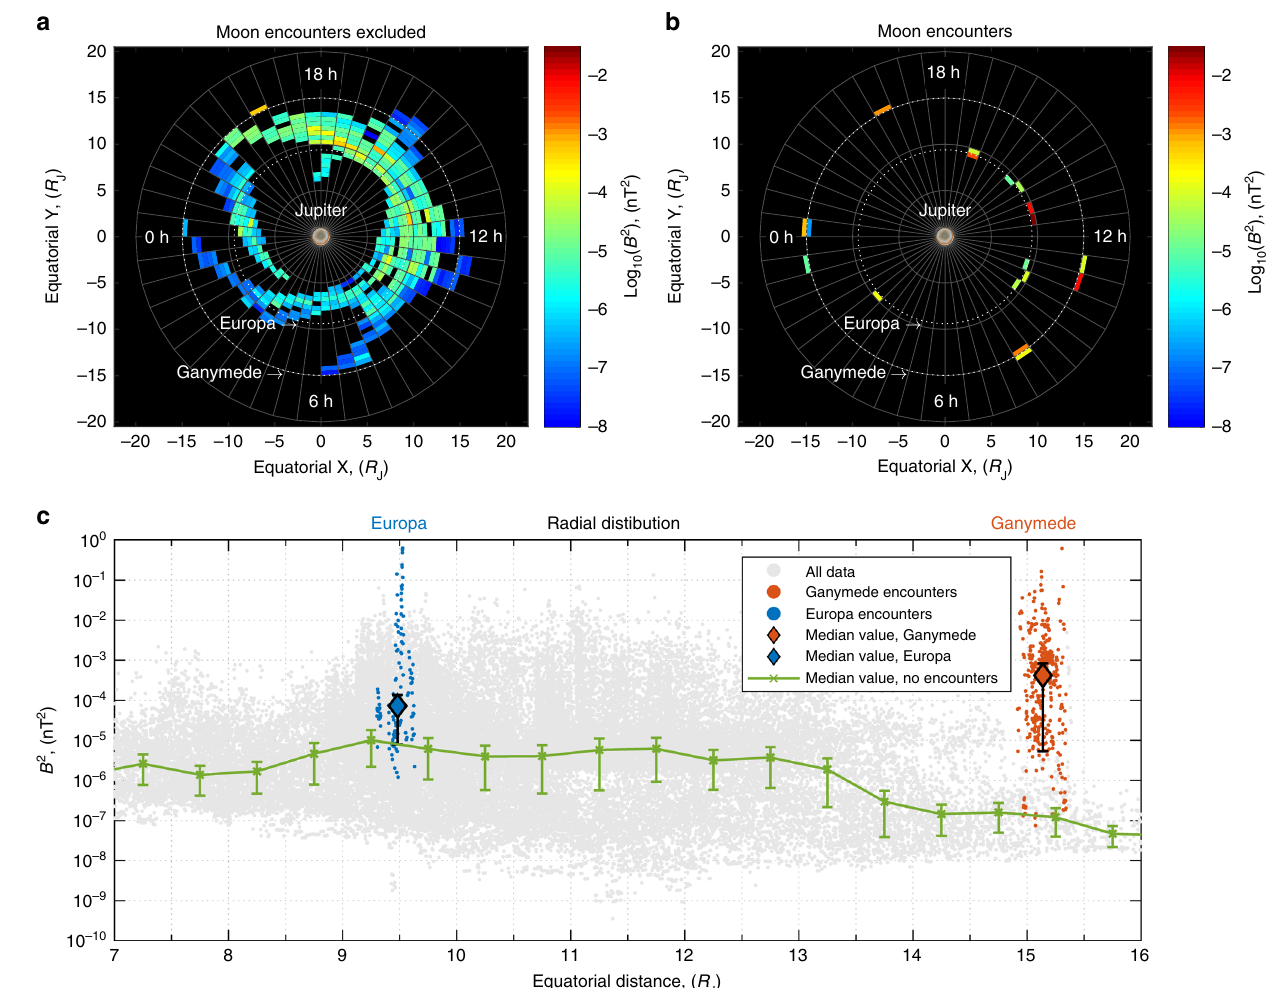
Fig. 1 Galileo mission wave power statistics: a Average chorus intensity in each bin ( Δ R J = 0.5, Δ MLT = 0.5 h) for the equatorial region from 27 June 1996 until 5 November 2002, excluding encounters with the moons. b Same as a but for encounters with Europa (~9.4 R J ) and Ganymede (~15 R J ), positive x is toward the Sun (noon MLT), axes are in the magnetic equatorial plane. c Scatter plot of wave power as a function of the distance from Jupiter. Blue dots show Galileo encounters with Europa. Red dots show encounters with Ganymede. Diamond points are median values during encounters. Green line shows median values of the wave power excluding encounters. The error bars are absolute mean deviation. Median wave power during the encounters for Ganymede and Europa signi fi cantly exceeds the median values at corresponding distances from